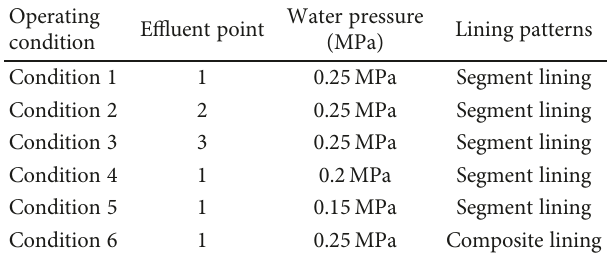
Table 5: Physical and mechanical properties of the lining.